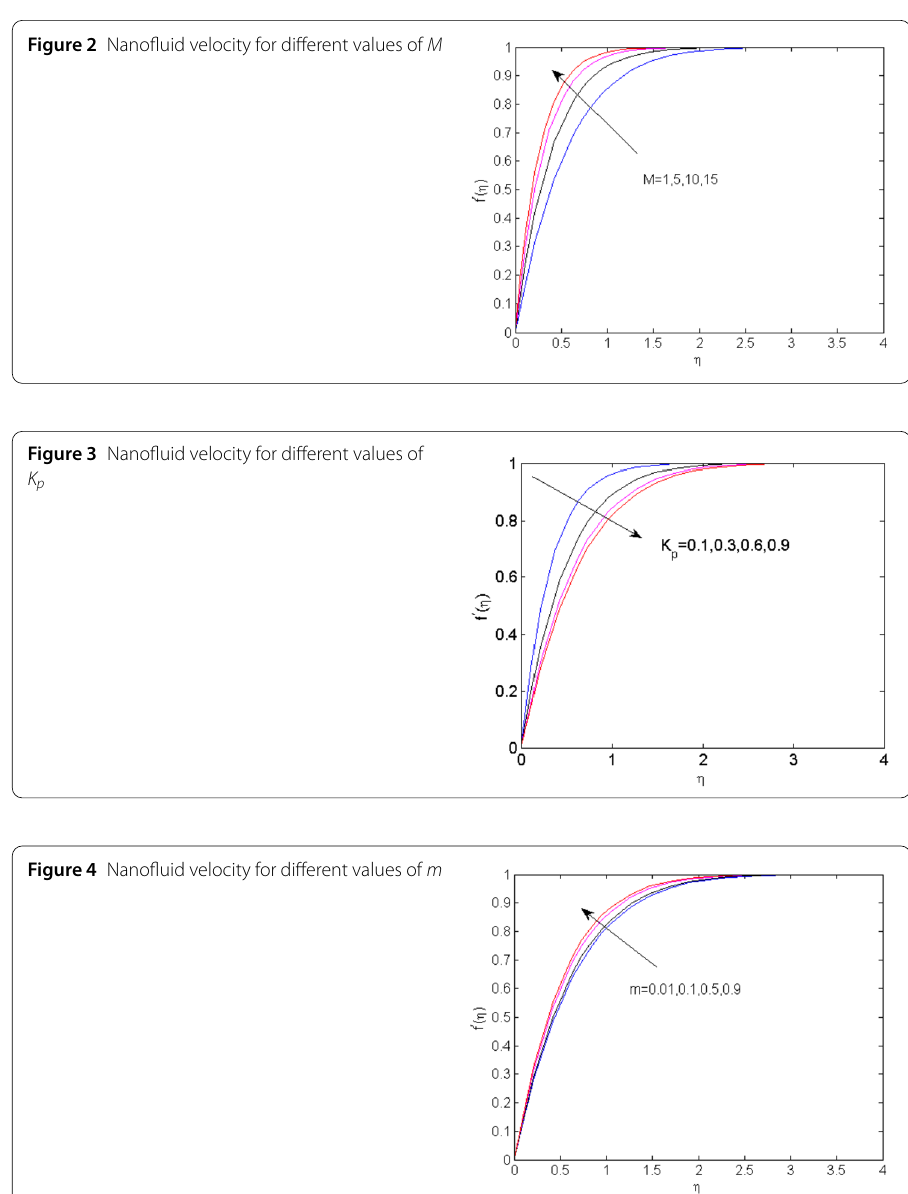
Figure 2 Nanofluid velocity for different values of M